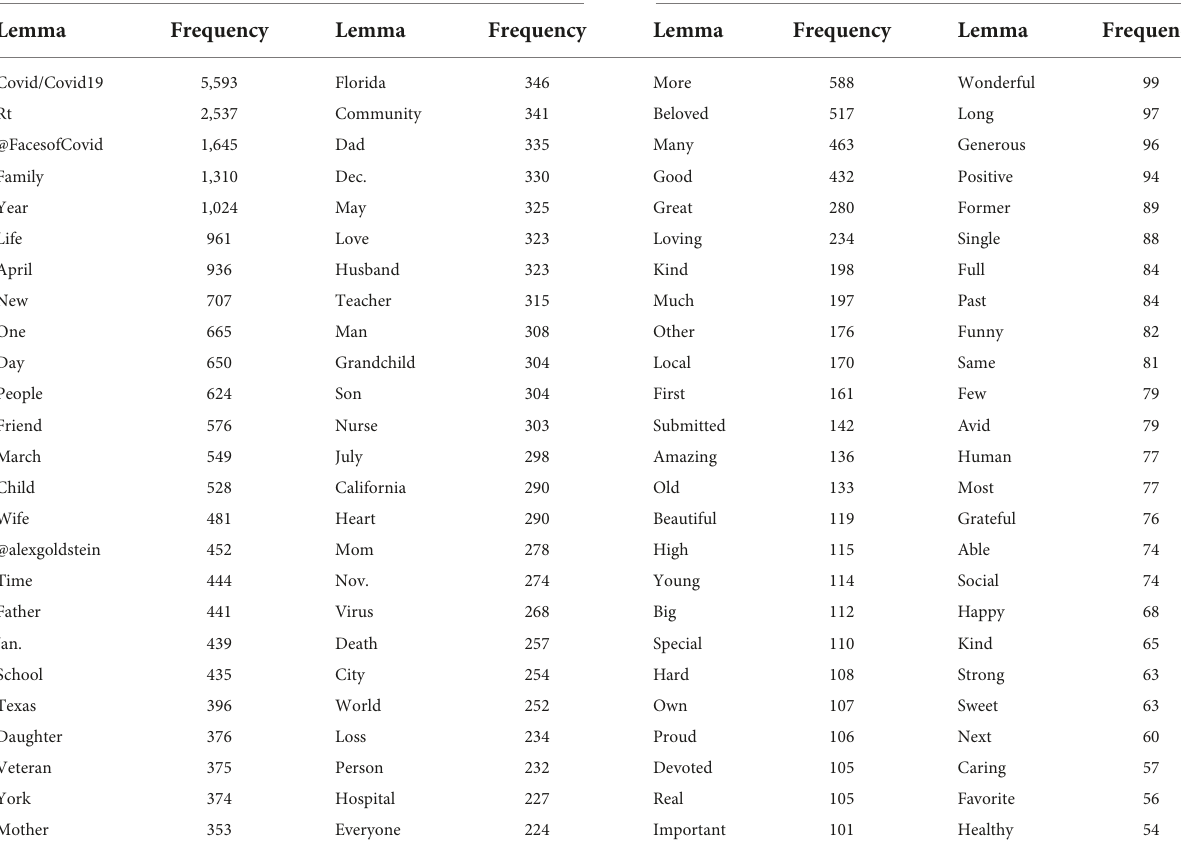
TABLE 1 The 50 top nouns and 50 top adjectives in the